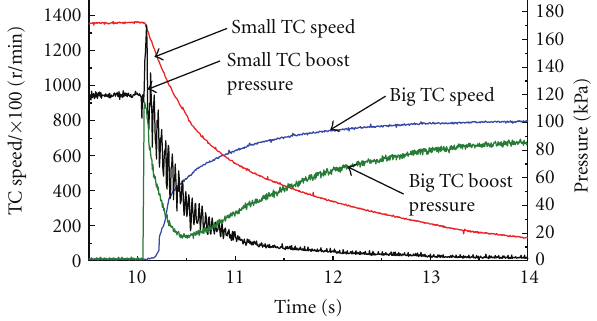
Figure 4: Process from the small TC to the big TC with the four valves activated synchronously.